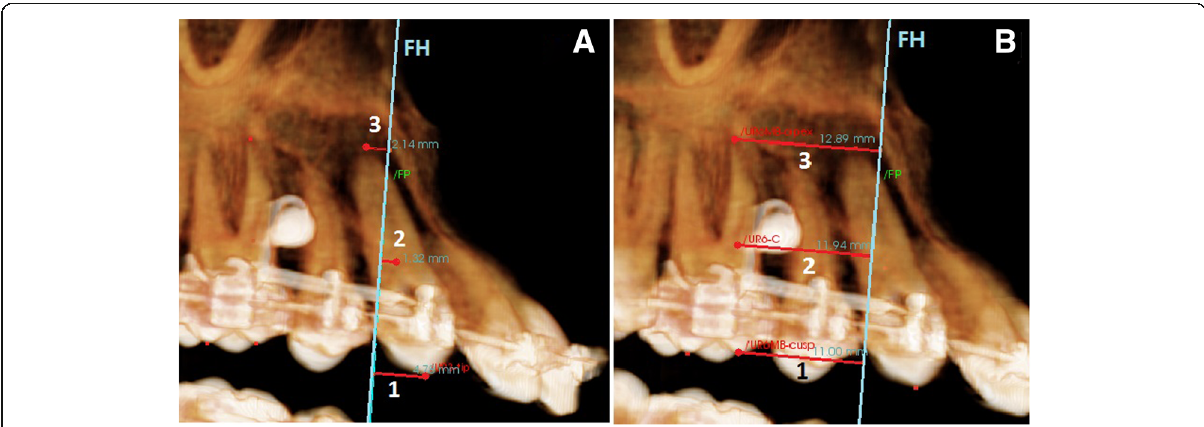
Fig. 3 Volumetric CBCT views showing a canine retraction measurements; 1: upper right canine cusp tip distance moved (from canine cusp tip to FP), 2: upper right canine center distance moved (from canine center to FP), 3: upper right canine root apex distance moved (from canine root apex to FP). b First molar anchorage loss measurements; 1: mesiobuccal (MB) cusp tip loss of anchorage (from MB cusp tip to FP), 2: Center loss of anchorage (from MB root center to FP), 3: MB root apex loss of anchorage (from MB root apex to